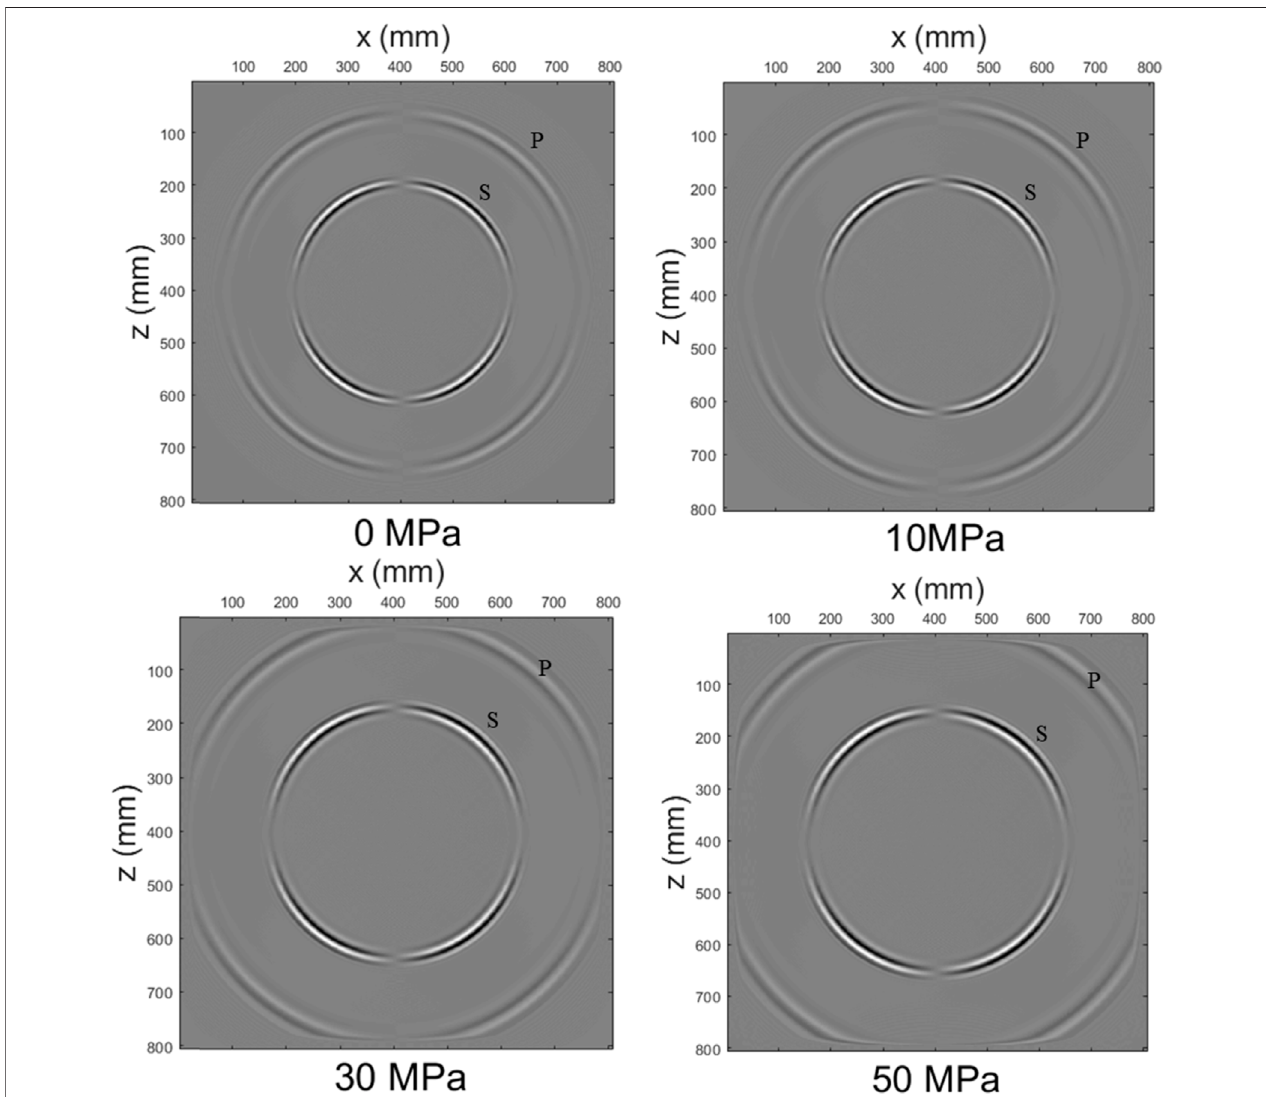
FIGURE 4 | Wave fi eld snapshots of the x -component of the particle velocity at t = 0.12 ms for various hydrostatic stresses.